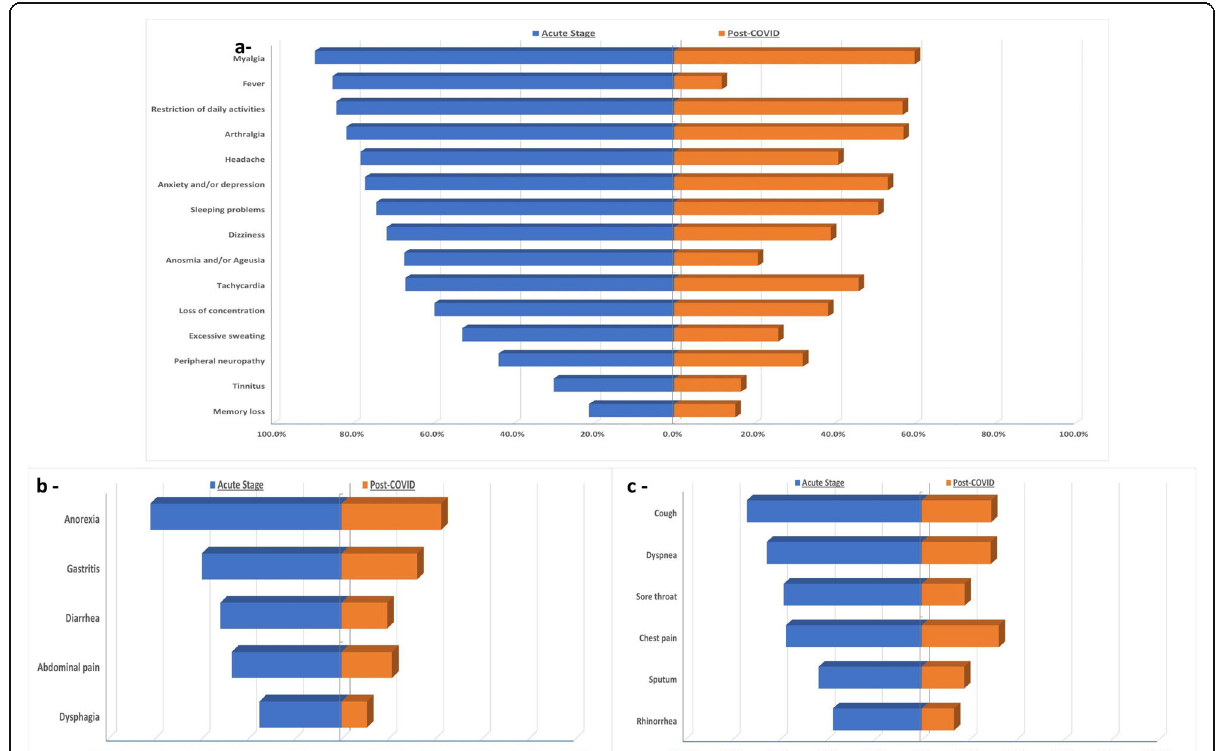
Fig. 1 Reported symptoms in acute and post- COVID stages: a general symptoms, b GIT symptoms, c respiratory